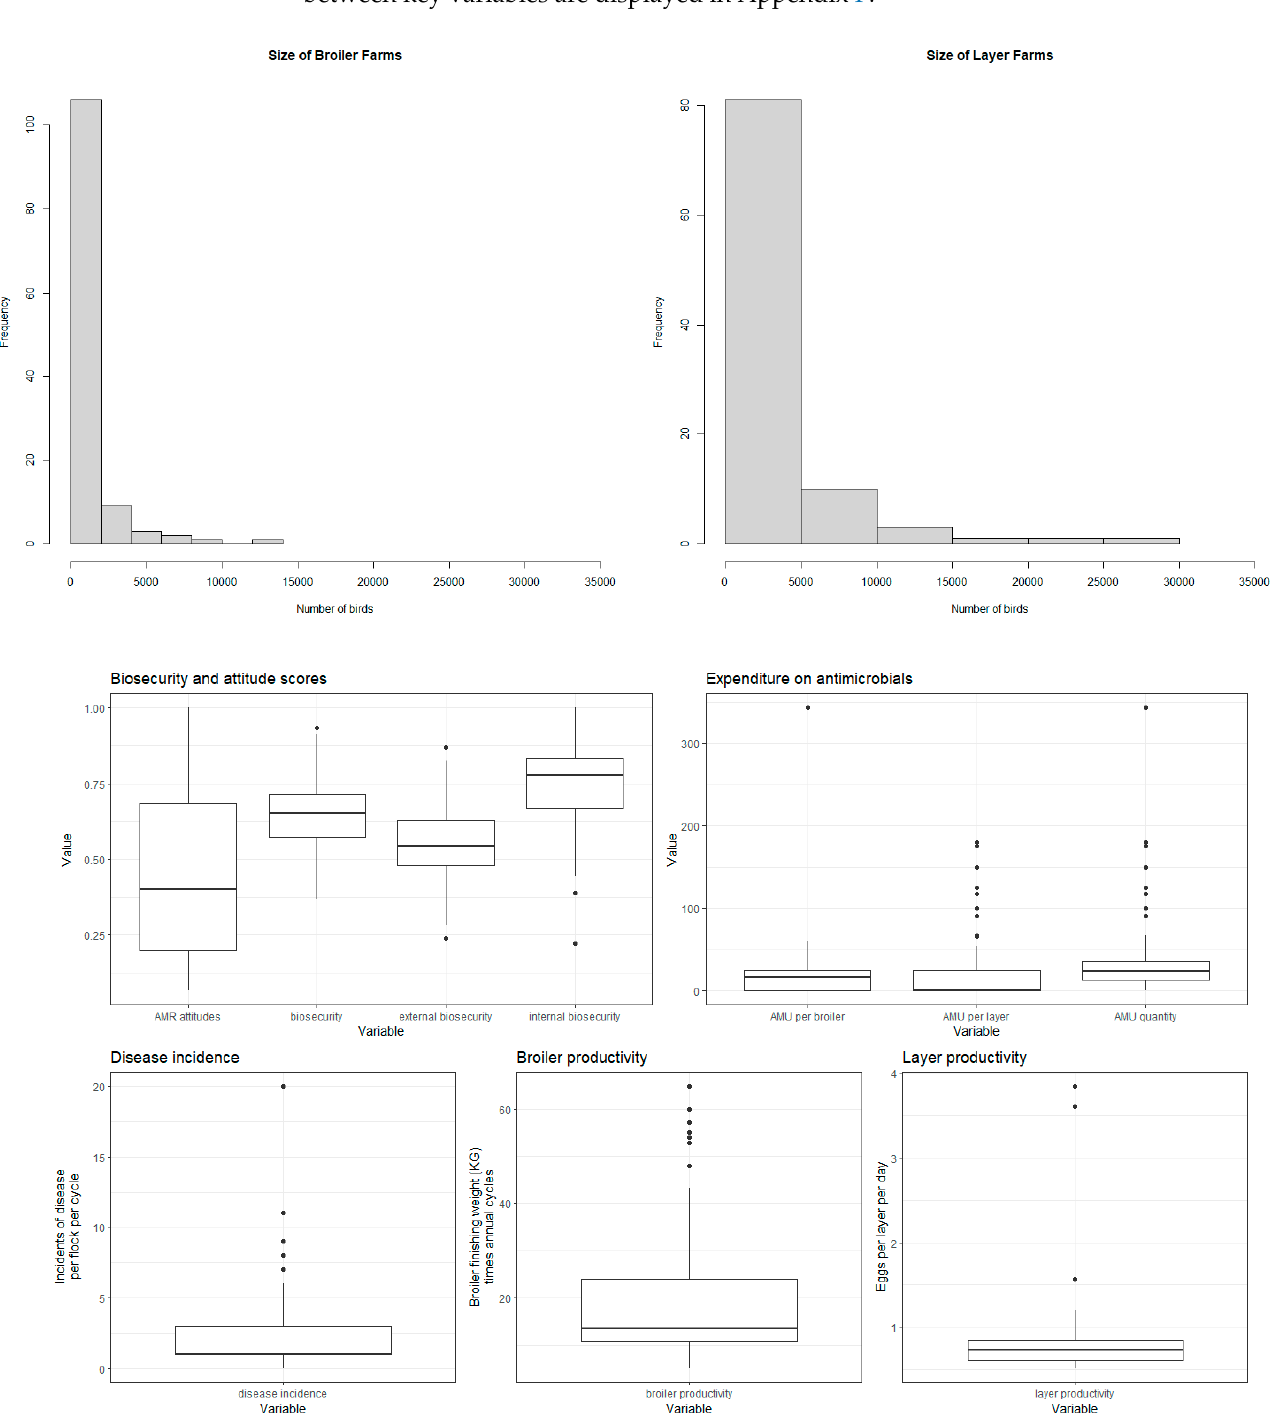
Figure 1. Distribution of continuous variables.